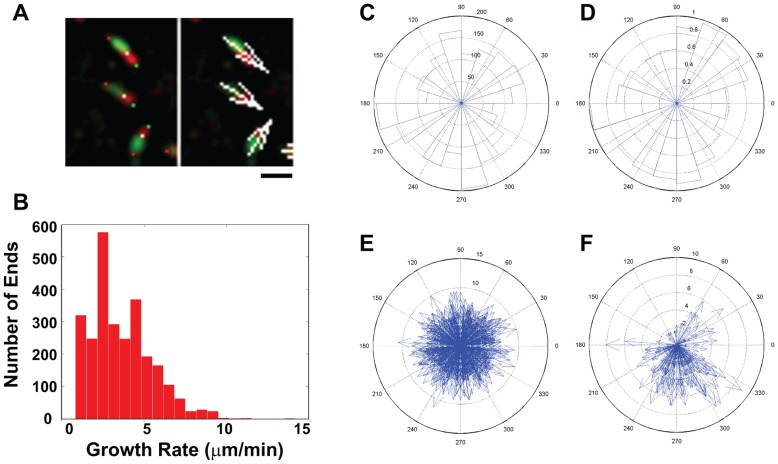
Analysis of microtubule growth rate and direction derived from single growing ends. A.Analysis of microtubule growth rate and direction in green-red ends. Rates are calculated as the distance between the front (green dots) and the rear (white dots) of red head, while directions are calculated from direction vectors connecting the rear of green tails (red dots) to the front of red heads (green dots). Growth vectors (shown by white arrows in left panels) are drawn from the back of green tails using normalized direction vectors scaled up to the quadruple of calculated rates. Scale bar: 1 µm. B. Histogram of growth rates calculated for all single green-red ends identified in the COS cell. C–D. Polar histogram plots of growth directions calculated for all single green-red ends from 12 dCCD frames of the COS cell in Figure S2A (C) or derived by the plusTipTracker program from the raw images of the same cell (D). E–F. Polar plots of growth rates against growth directions of single green-red ends from 12 dCCD images of the entire COS cell (E) or the boxed region (F) shown in Figure 5B. The numbers between 60° and 90° indicate the actual number of ends (C), the normalized end number ratio (D), or the growth rate in µm/min (E–F).